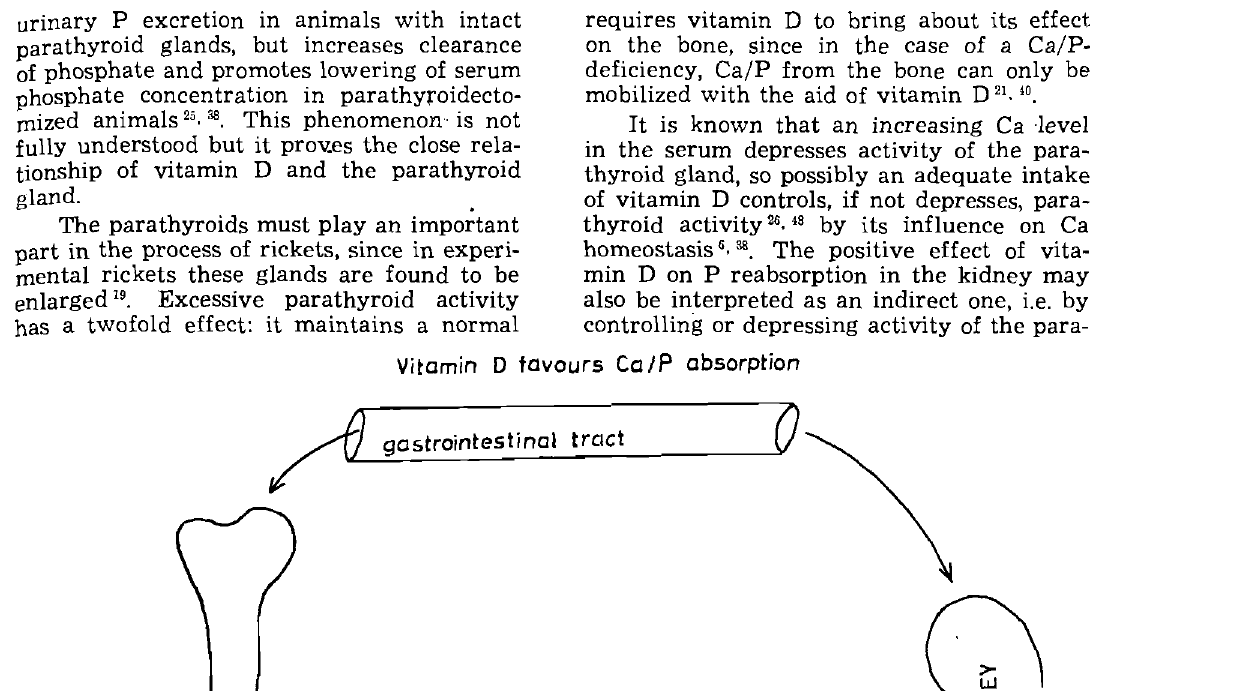
Fig. 2: Schematic representation of the effect of vitamin D, parathyroid hormone and thyrocalcitonin on the move ment of Ca and P. Vitamin D and parathyroid hormone act partly as synergists and partly as antagonists 34• Parathyroid hormone favours CalP absorption (of minor